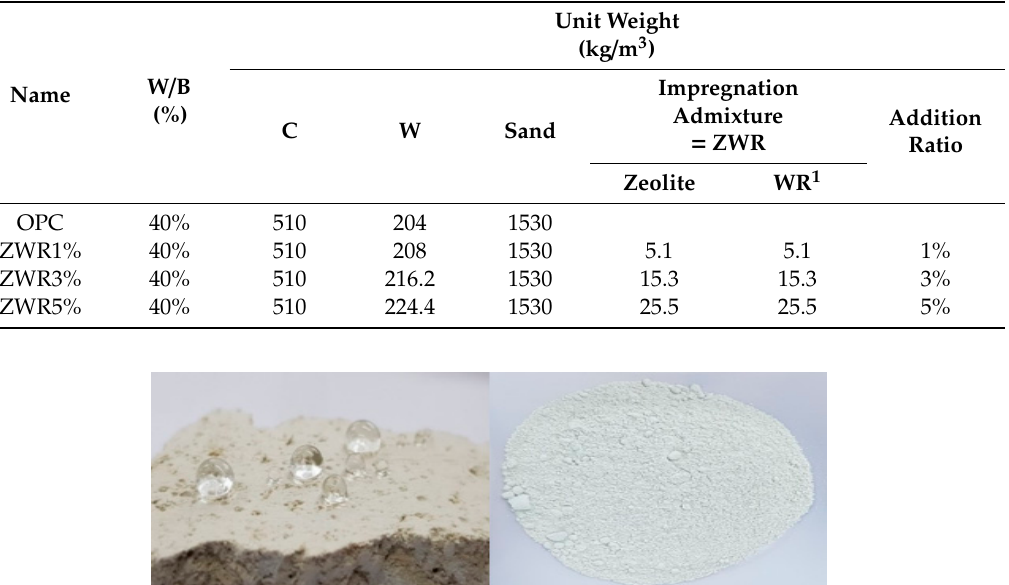
Table 5. Cement mortar mix proportion.